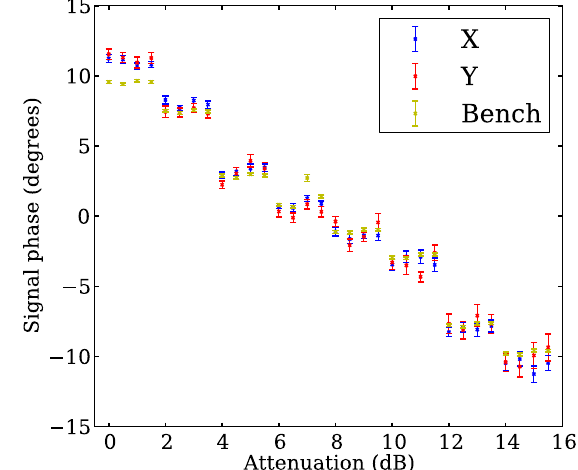
FIG. 8. Phase of the signals from the horizontal and vertical position cavity channels relative to the phase of the reference cavity signal for different settings of the variable attenuator. The attenuation in the reference channel was kept constant. Data from the bench measurement of the variable attenuator is included and all three data sets are mean